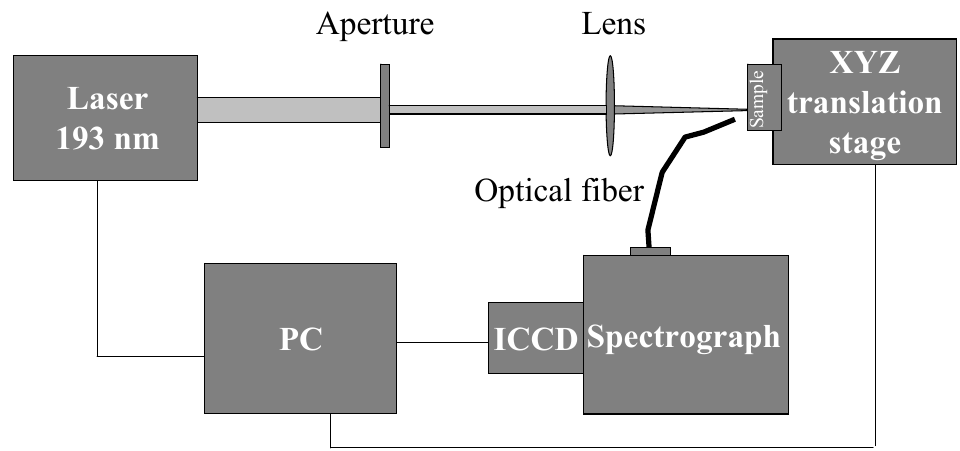
Figure 1. The LIPS setup used in the toner analysis.